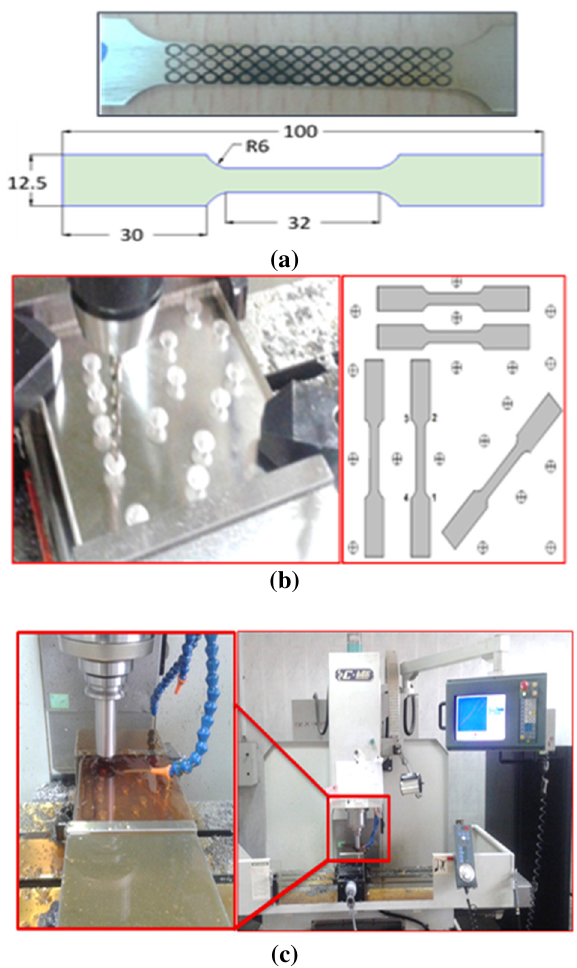
Fig. 2. (a) Dogbone sample (b) Drilling system (c) Cutting process of dogbone